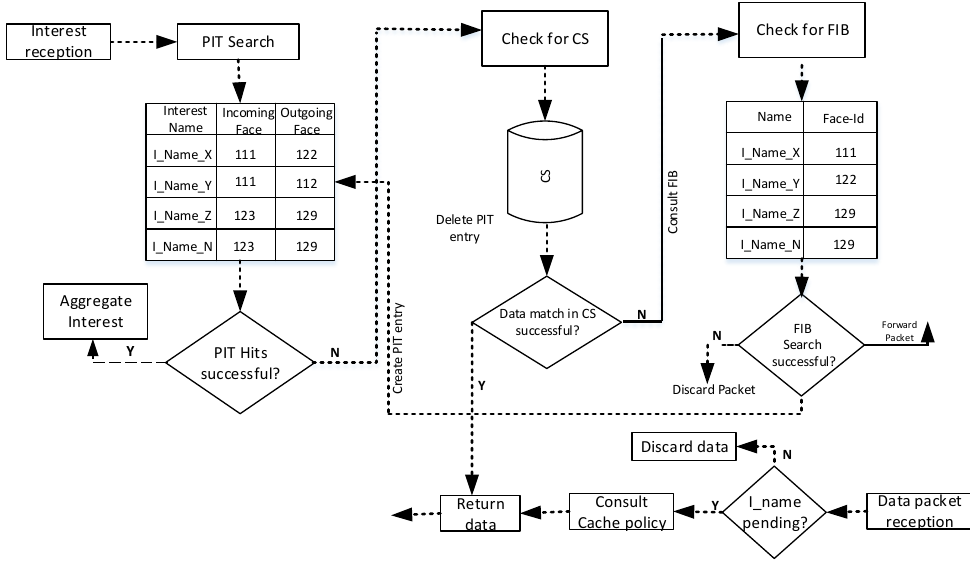
Figure 1. NDN communication